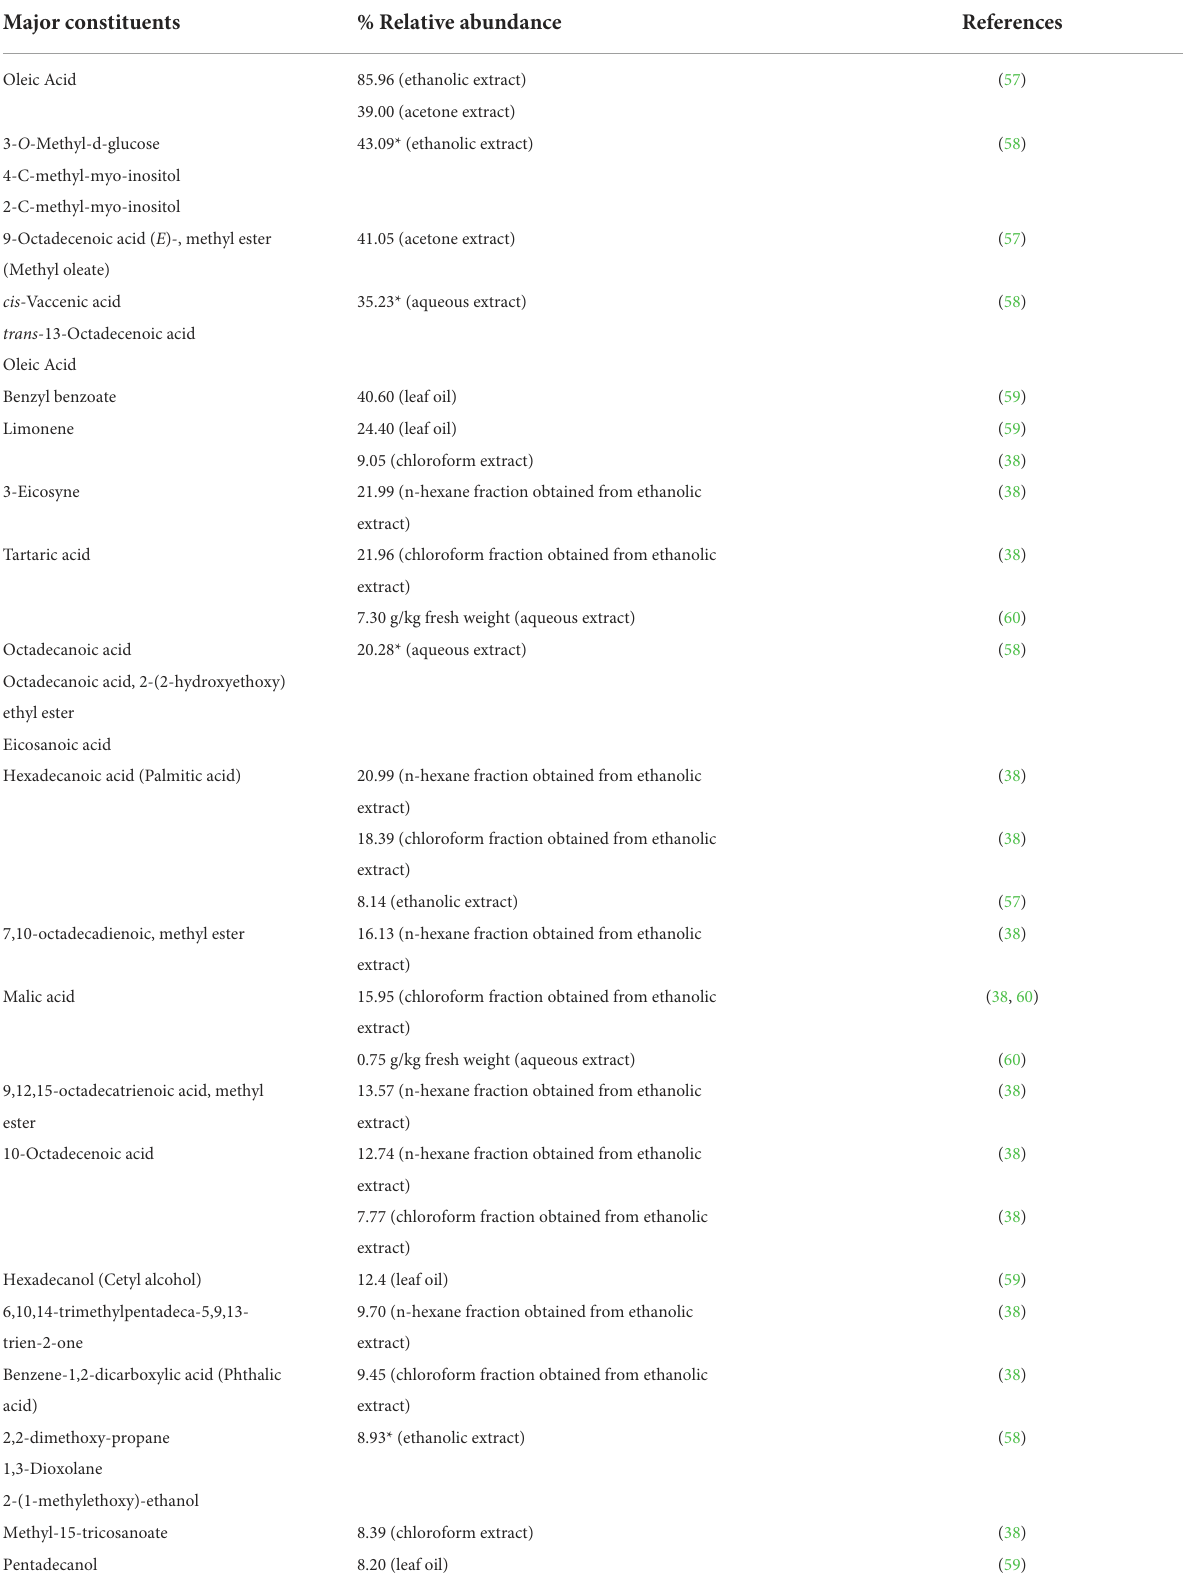
TABLE 4 Major phytochemical compositions in T. indica